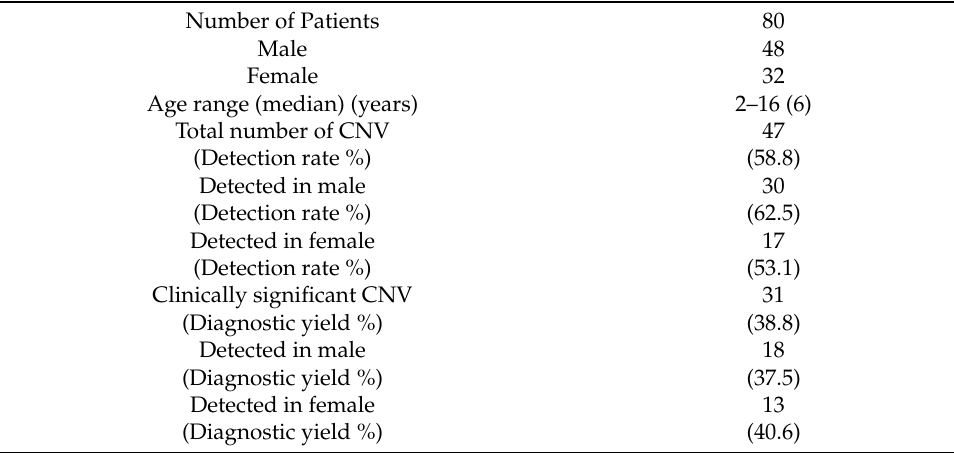
Table 1. Summary of patient characteristics and CNV findings; CNV, copy number